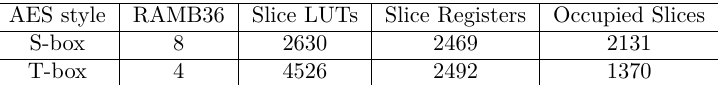
Table 2: Cost of S-box and T-box AES implementations.